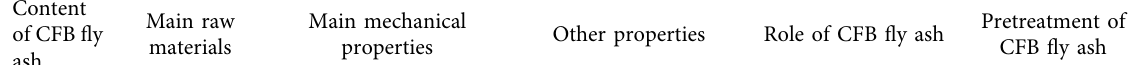
Table 2: Application of CFB fy ash in Portland